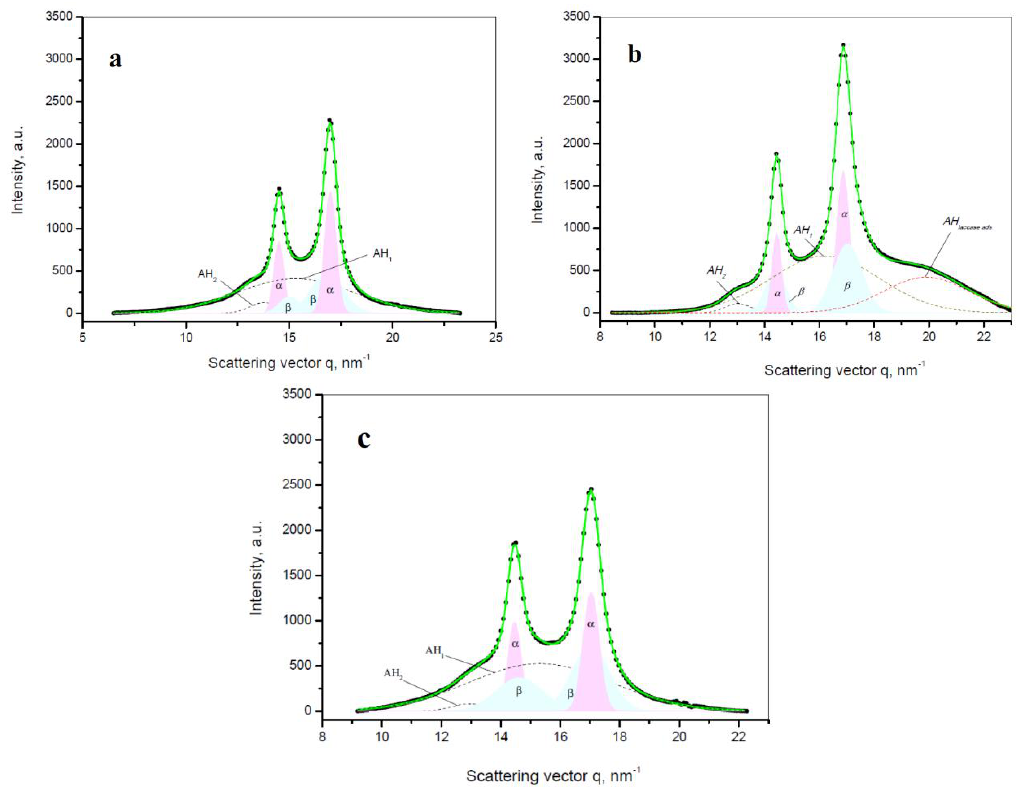
Figure 8. Examples for WAXS pattern deconvolution by peak fitting: ( a ) PA4 support; ( b ) PA4-iL; ( c) PA4-eL. Table 6. WAXS analysis of empty PA4 supports and PA4-laccase conjugates.